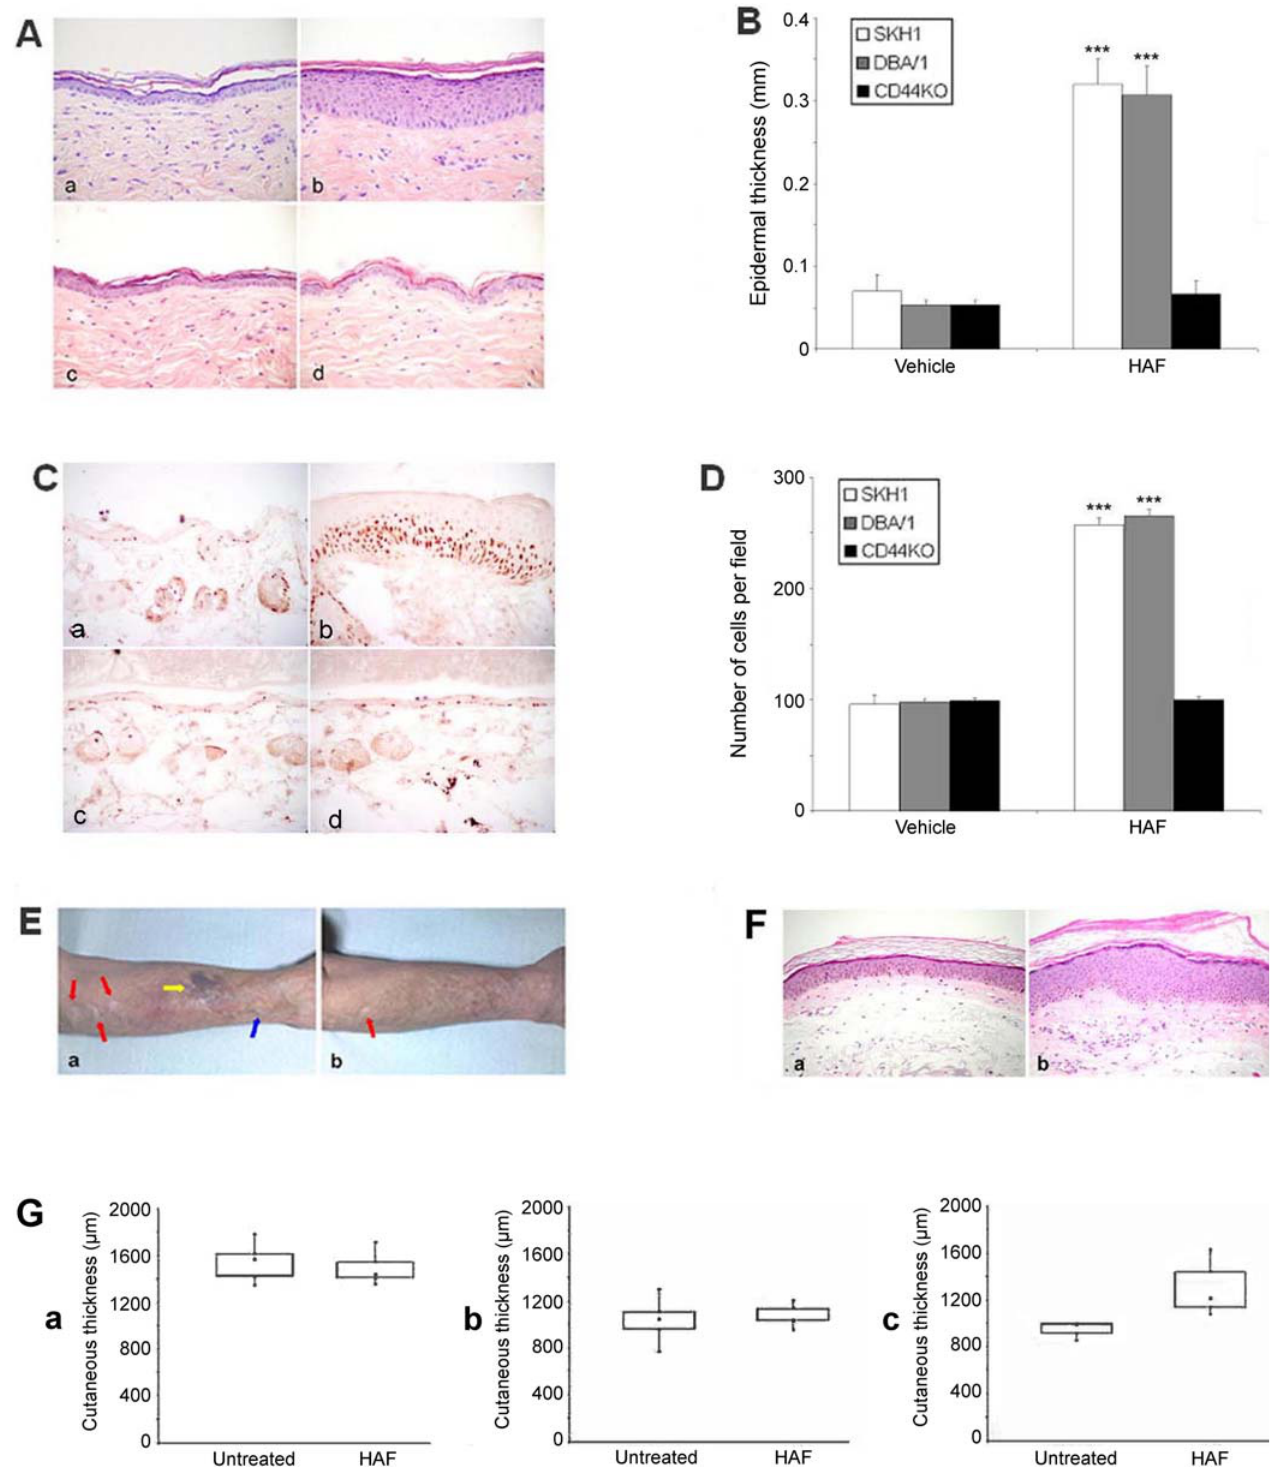
Figure 2. The Effect of HAF on Mouse and Human Skin (A) HAFi-induced hyperplasia of mouse skin is CD44 dependent. Histological sections of vehicle-treated (a and c) or HAFi-treated (b and d) DBA/1 (a and b) or CD44 (cid:1) / (cid:1) (c and d) dorsal mouse skin. Note the epidermal hyperplasia in DBA/1 but not in CD44 (cid:1) / (cid:1) mice. (B) Epidermal thickness in vehicle- or HAFi-treated SKH1, DBA/1, and CD44 (cid:1) / (cid:1) mouse back skin measured with an ocular micrometer. Ten measurements were performed per mouse, and the average value was calculated. The results are presented as the mean epidermal thickness 6 SEM of six animals per group. *** p , 0.001 versus vehicle (Student’s t-test). (C) In vivo proliferative response of mouse epidermis to HAFi is CD44 dependent. Ki67 staining of vehicle-treated (a and c) or HAFi-treated (b and d) DBA/1 (a and b) or CD44 (cid:1) / (cid:1) (c and d) dorsal mouse skin. (D) Dermal cellularity in vehicle- or HAFi-treated SKH1, DBA/1, and CD44 (cid:1) / (cid:1) mouse back skin. Samples were counted at 40 3 magnification. Ten counts PLoS Medicine |